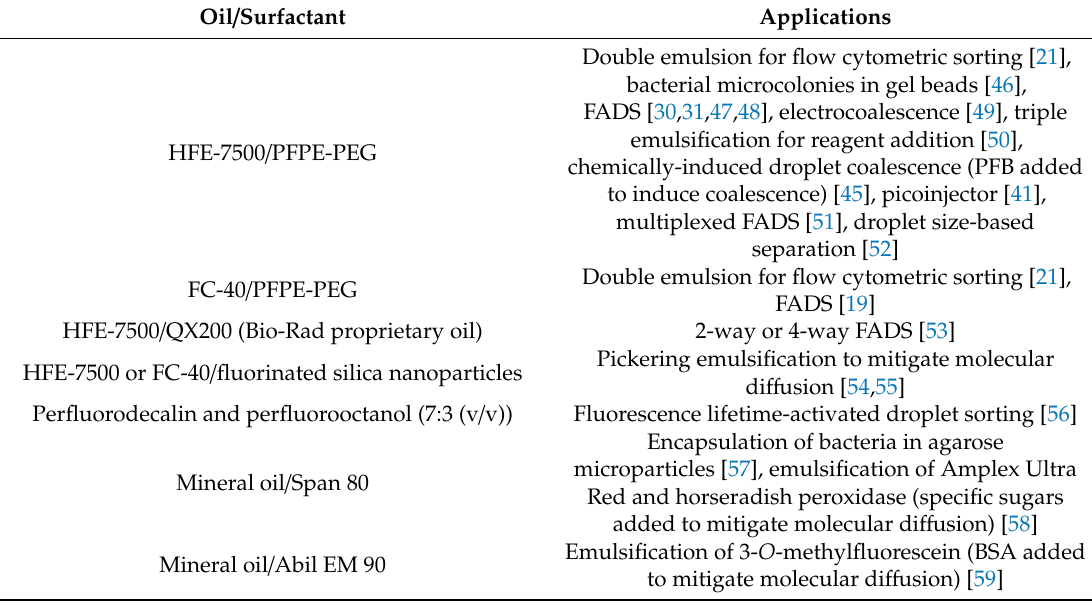
Table 1. Oil / surfactant formulations used in the studies that are discussed in this